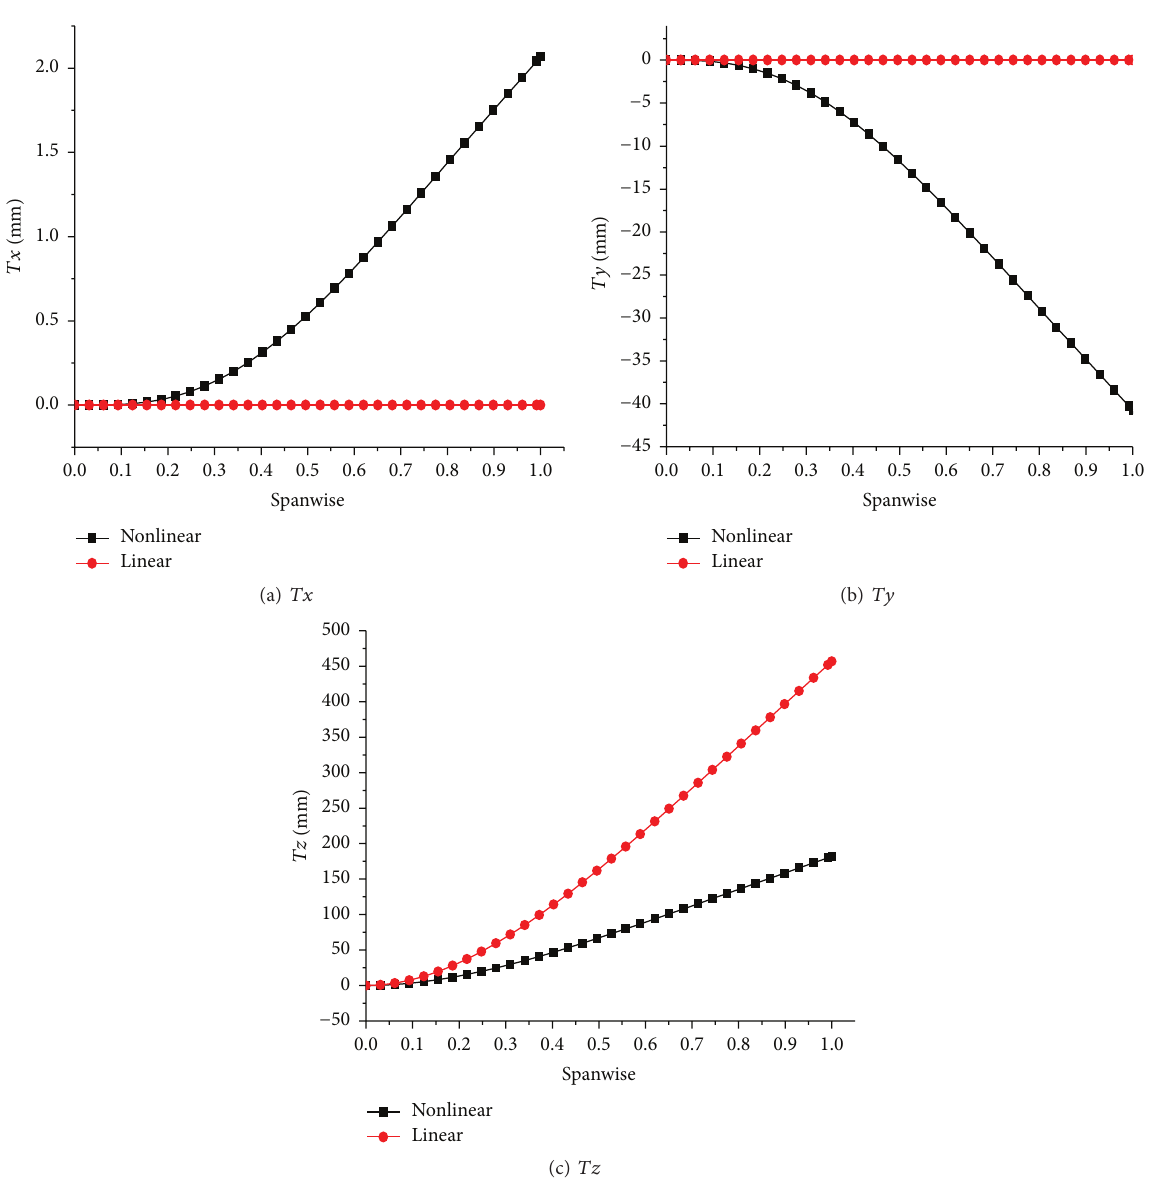
Figure 13: Displacement of the wing spar spanwise (0.5 ∘ AOA, 34